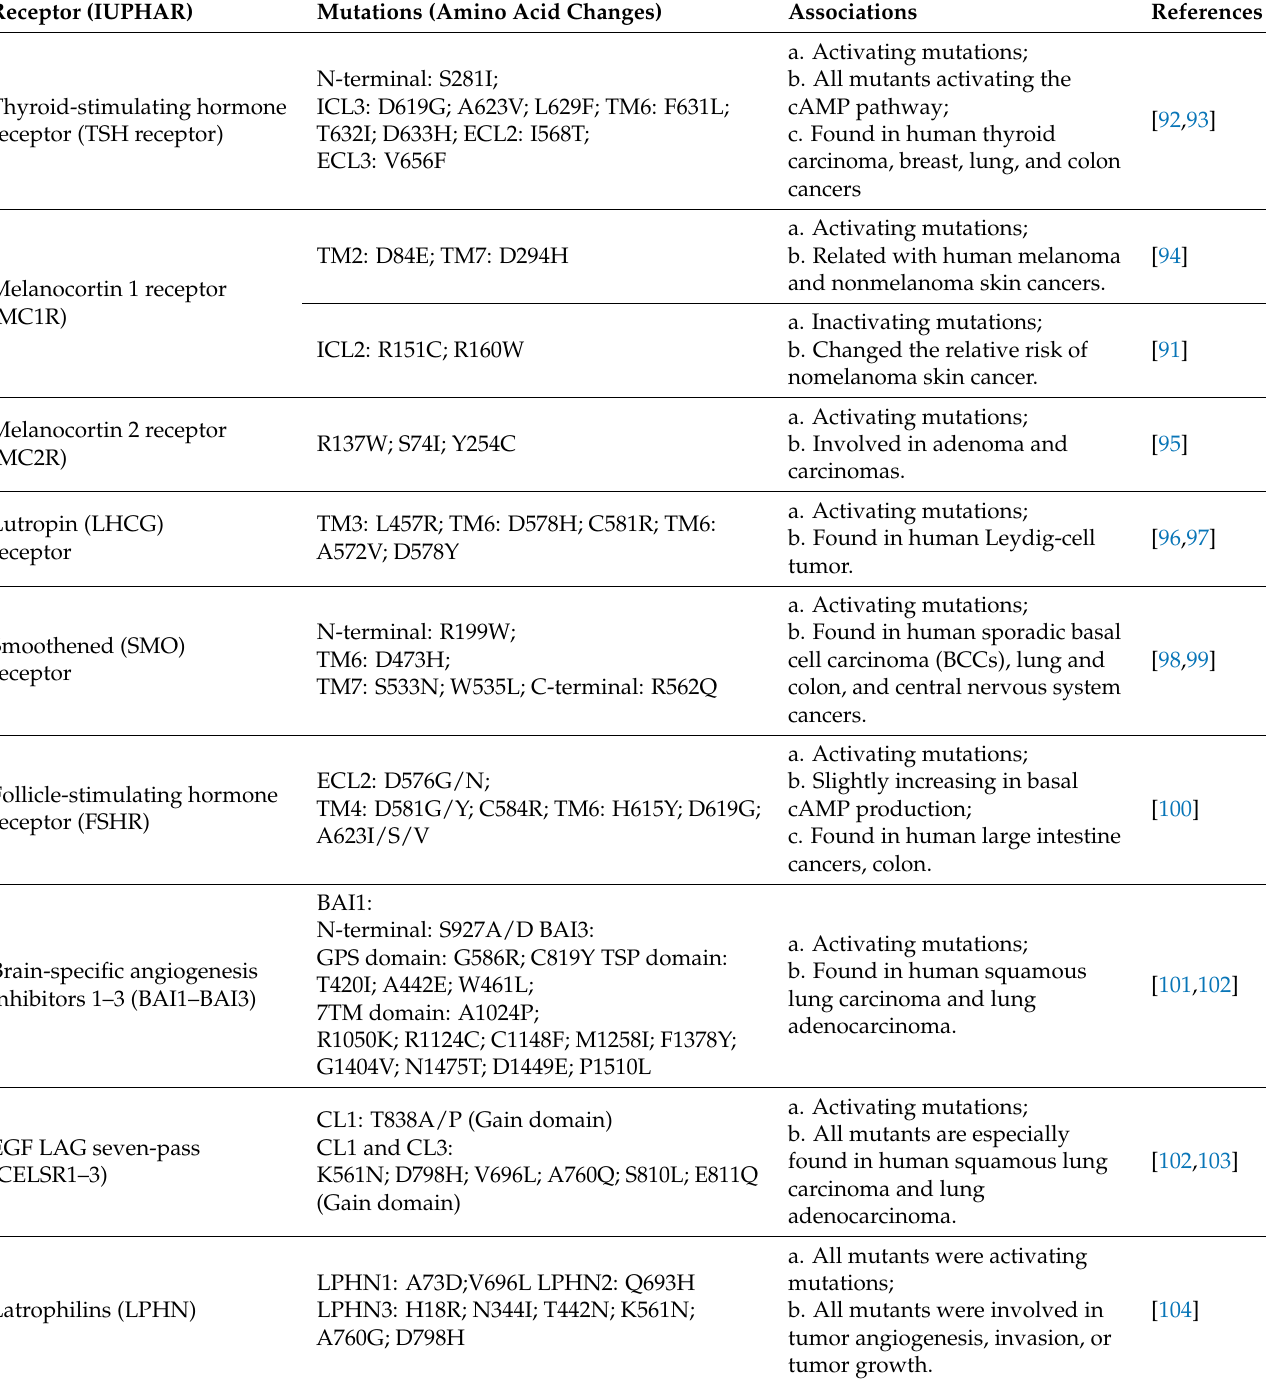
Table 2. Lists of activating/inactivating mutations of GPCRs in various